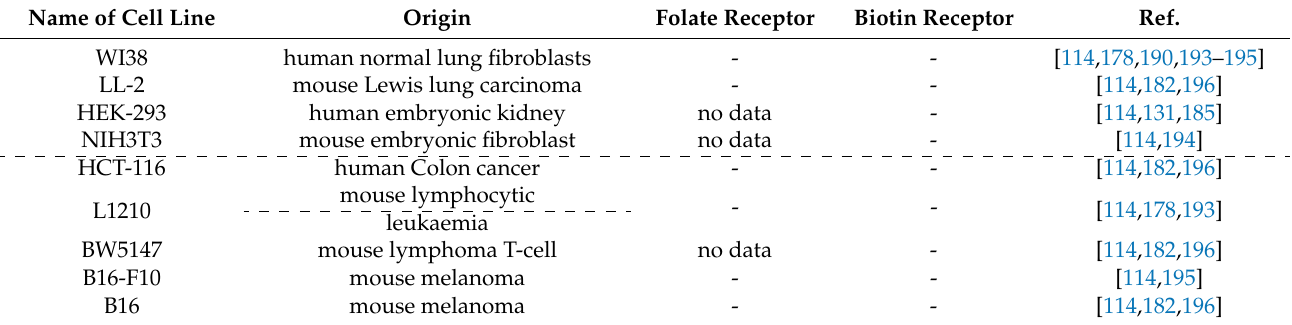
Table 8. Various cell lines with negative biotin or folate receptor